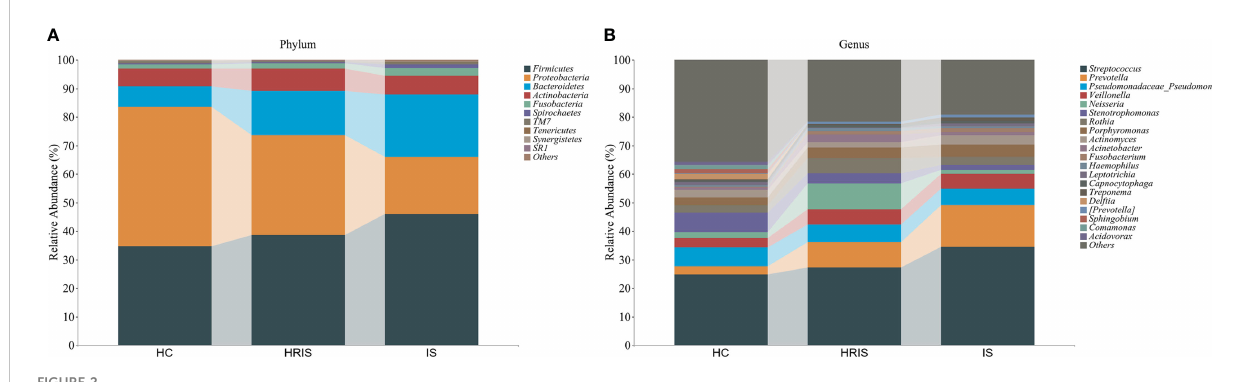
analyses between the two groups (Supplementary Figures 3A, B). Furthermore, at the genus level, LEfSe analysis revealed a higher relative abundance of g_Macellibacteroides , g_Pseudimonas , g_Ruminococcus , g_Caulobacter , g_Ralstonia , and g_Aquabacterium in the LAA, whereas g_Veillonella was more abundant in the SAA (Supplementary Figure 3C).